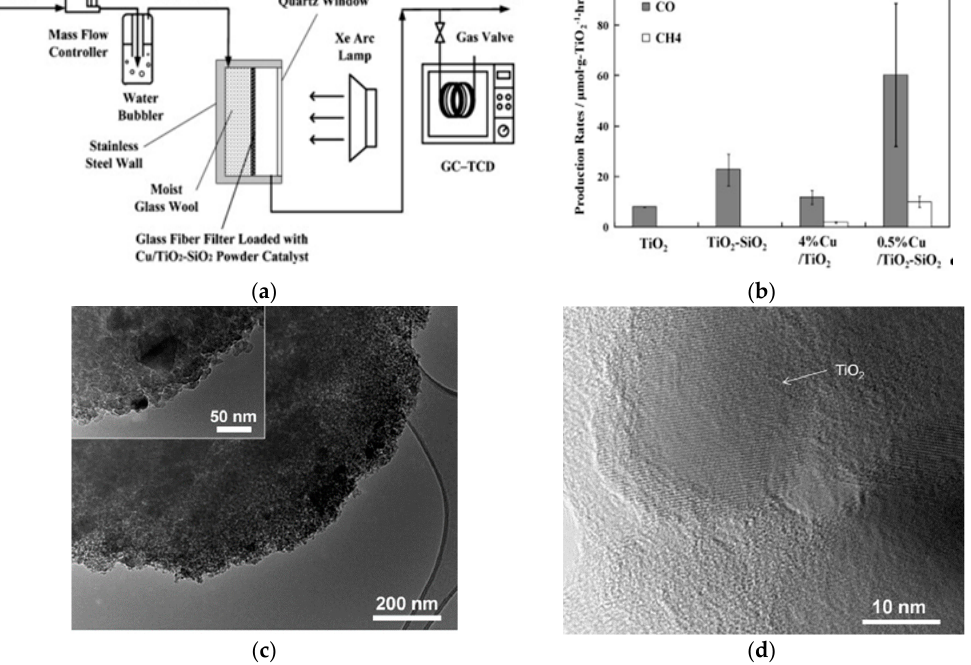
Figure 15. Photocatalytic reduction of CO 2 on ordered mesoporous silica supported Cu/TiO 2 . ( a ) Schematic representation of experimental set-up; ( b ) production rates of CO and methane; ( c ) transmission electron microscopy (TEM) image of the 0.5 wt.% Cu/TiO 2 -Silica composite; ( d ) high resolution TEM image of a single TiO 2 nanoparticle. Reproduced from work in [106] . Copyright 2010 Elsevier B.V.